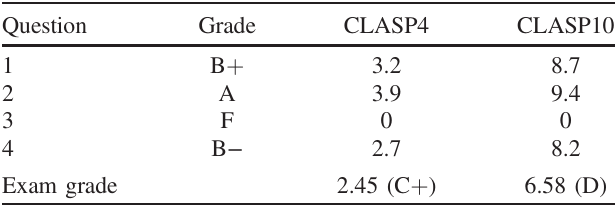
TABLE II. Grades a student might earn on an exam with 4 problems when the third problem was left blank. The resulting exam grade is calculated, by averaging, using either of the two CLASP grade scales (see Table I). Leaving an answer blank clearly carries much more weight in averaging under